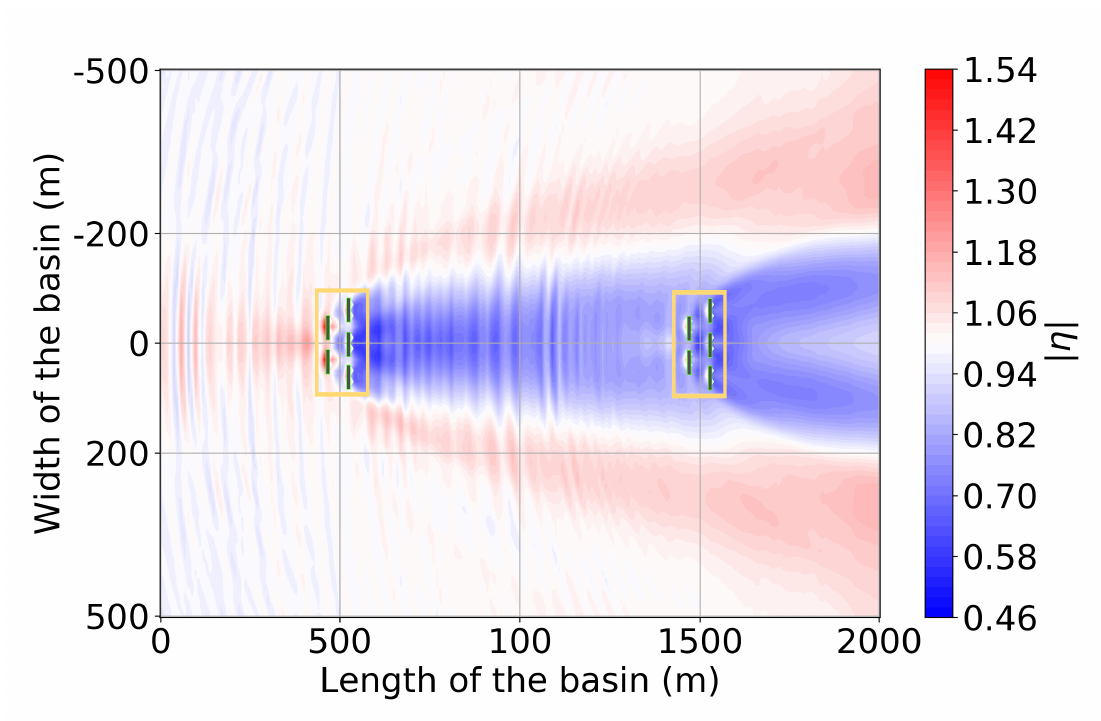
Figure 13. Coupled total wave amplitude | η | for H s = 2.0 m, T p = 10.0 s and β = 0 ◦ regular wave for a 10 WEC 2-Array farm over a sloping bathymetry shown in Figure